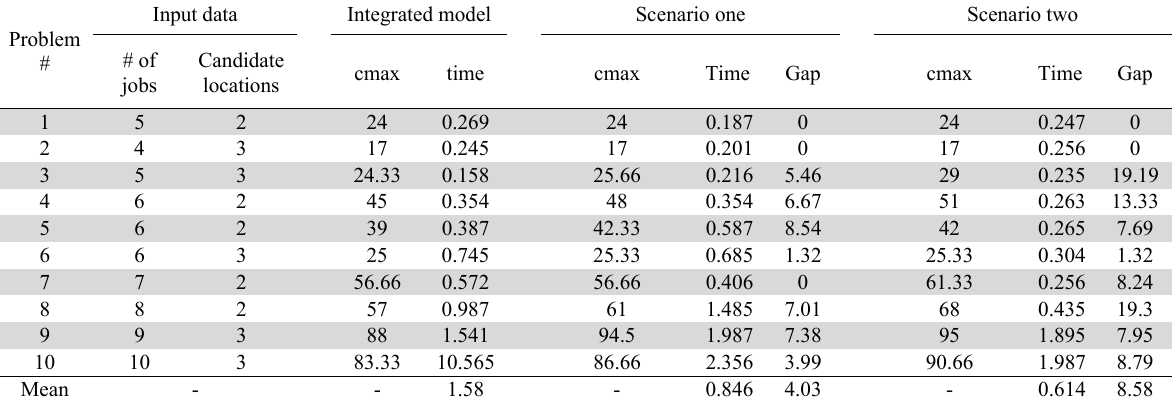
Table 11 The results of the optimal solution for 10 sample test problems Input data Integrated model Scenario Problem #